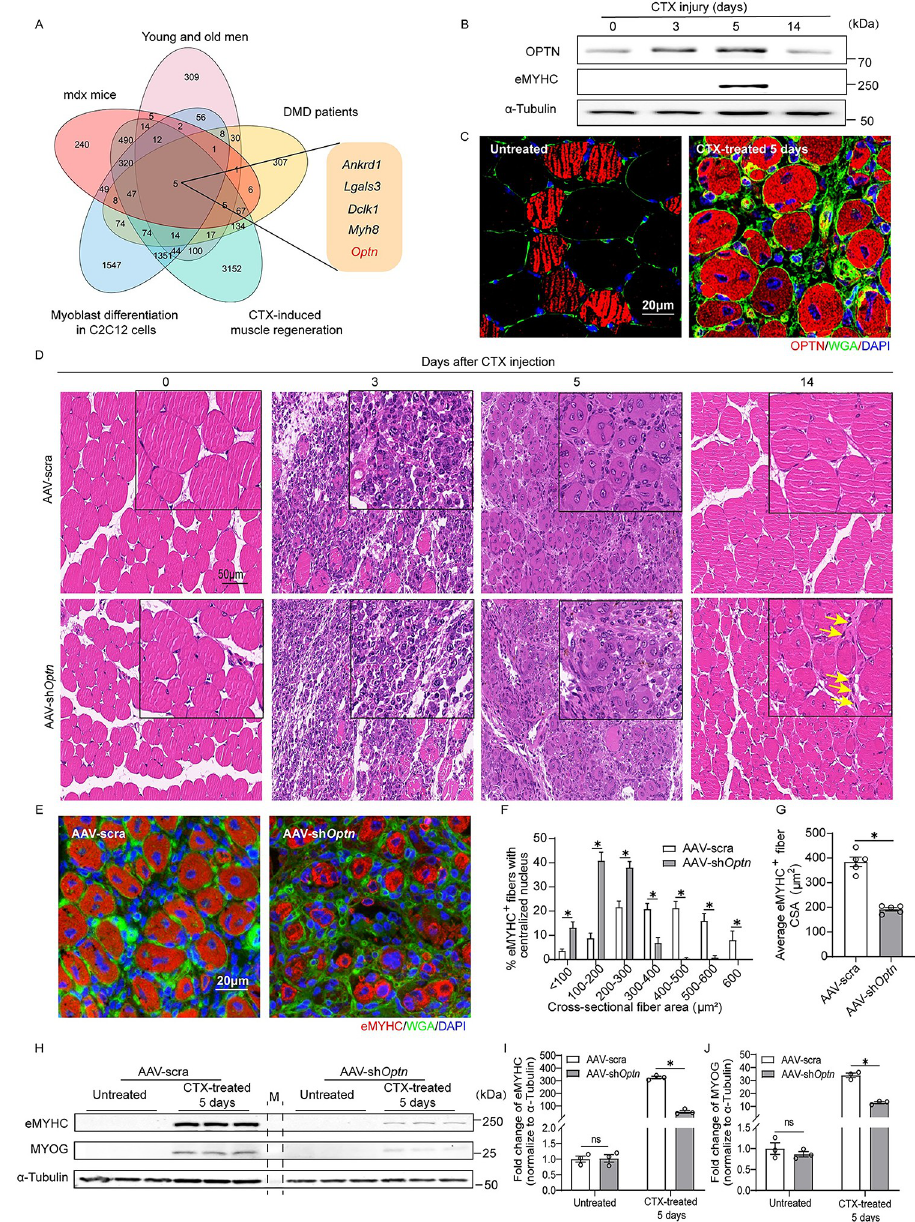
Fig 1. OPTN is essential for myogenesis during skeletal muscle regeneration in response to muscle injury. (A) Venn diagram showing 5 overlapping DEGs among 5 independent microarray datasets related to myogenesis or muscle atrophy. (B) Representative immunoblotting analysis of eMYHC and OPTN in TA of WT mice at 0, 3, 5, and 14 days postinjury ( n = 3 mice in each group). (C) Representative immunofluorescence analysis of OPTN subcellular distribution in TA muscle at CTX untreated or 5 days postinjury. The OPTN, the sarcolemma, and the nucleus were stained with anti-OPTN antibody (red), WGA (green), and DAPI (blue), respectively. Scale bars: 20 um. (D) Representative HE staining of TA at 0, 3, 5, and 14 days postinjury in scramble shRNA or sh Optn mice. The yellow arrowheads indicate inflammatory cells infiltration. Scale bar: 50 μ m. (E) Representative immunofluorescence staining of eMYHC + fibers in scramble shRNA or sh Optn TA muscle at 5 days postinjury. Scale bar: 20 μ m. (F) Distribution of eMYHC + myofiber CSAs in scramble shRNA or sh Optn TA muscle at 5 days postinjury ( n = 5 mice in each group). (G) Average CSA of regenerating eMYHC + myofibers in scramble shRNA or sh Optn TA muscle at 5 days postinjury ( n = 5 mice in each group). (H–J) Representative immunoblotting analysis (H) and quantification (I, J) of myogenic markers (eMYHC and MYOG) in scramble shRNA or sh Optn TA muscle ( n = 3 mice in each group) at 5 days postinjury. M, marker. Data are presented as mean ± SEM. � P < 0.05 versus control. The underlying data for